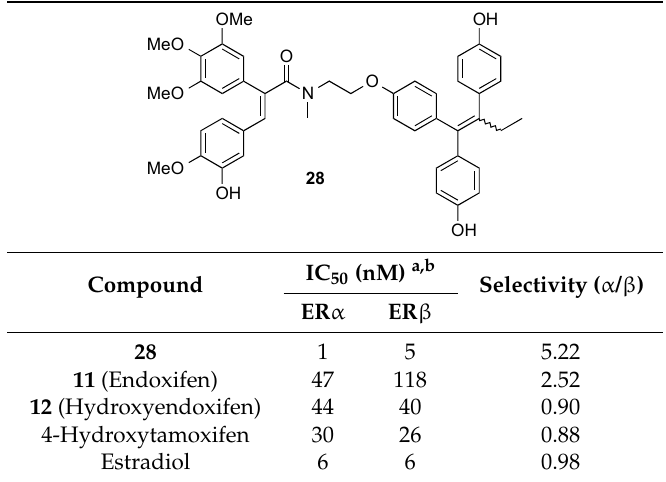
Table 4. Estrogen receptor binding affinities for compounds 11 , 12 and 28 a .